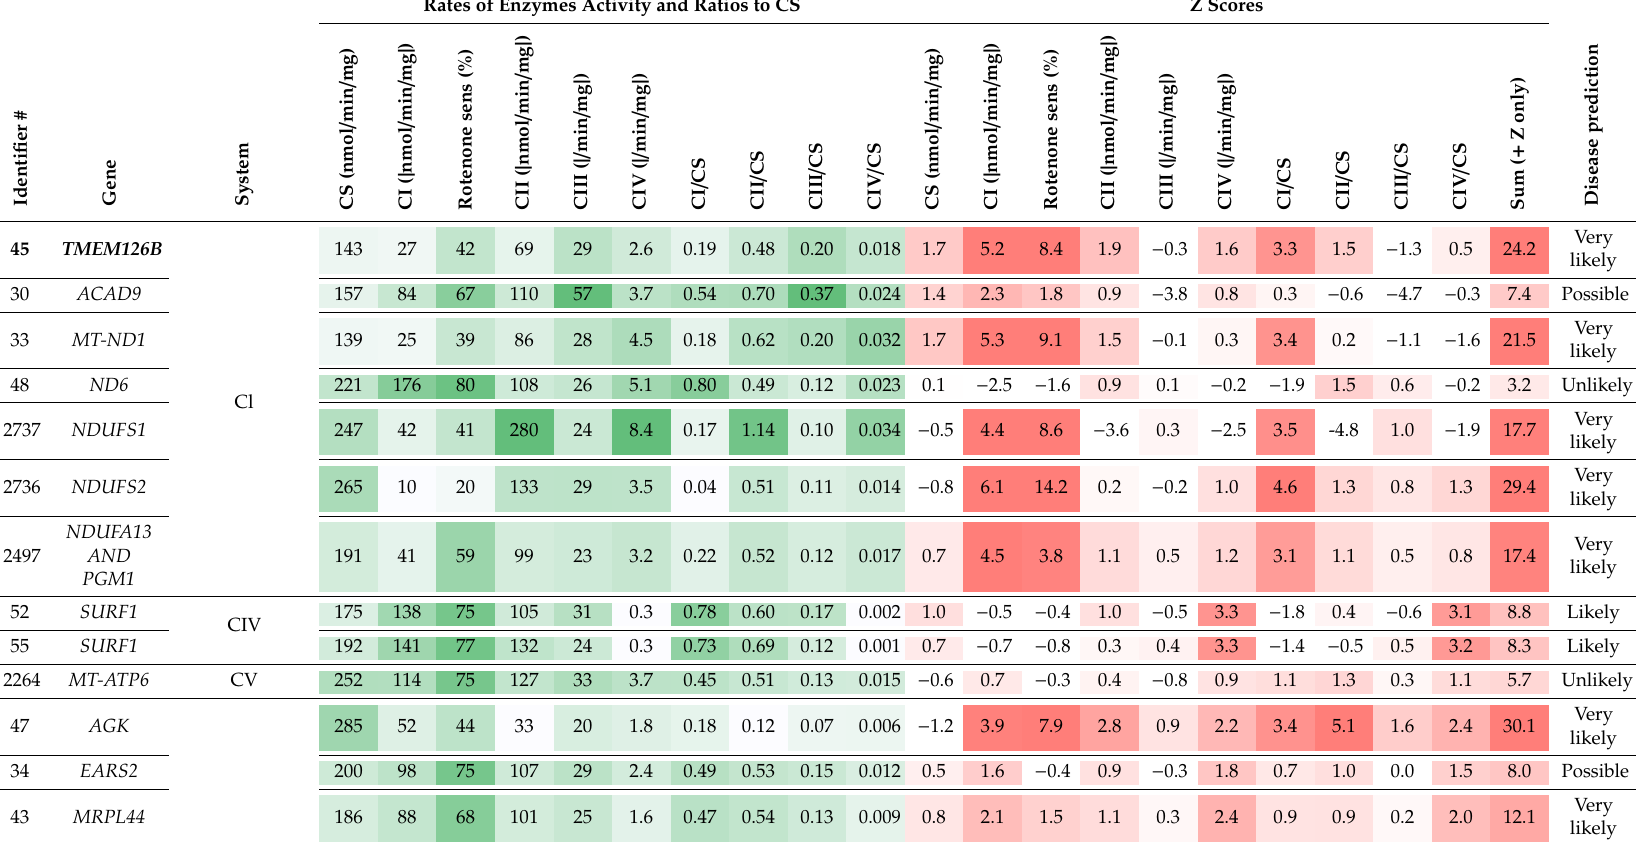
Table 2. Enzymological testing results and disease predictions. Enzymology values for individual PMD patient cell lines as grouped based on the system e ff ected. Disease prediction was assigned using Z scores, as described in the Materials and Methods. Abbreviations: CI–IV, respiratory chain complexes I–IV; CS, citrate synthase; Str,